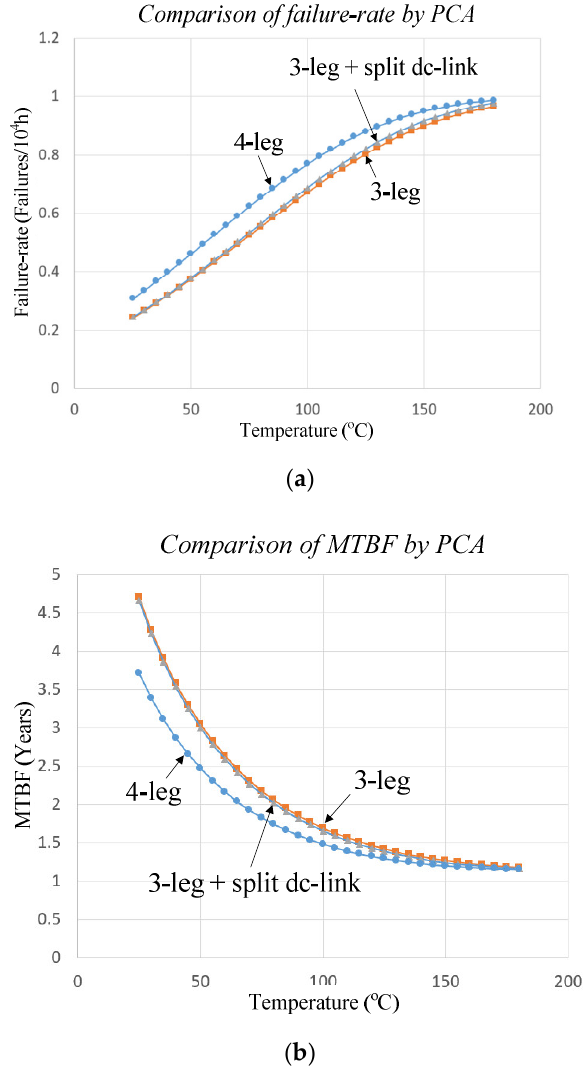
Figure 8. Comparison of failure rate and mean time between failures (MTBF) by part count failure analysis (PCA): ( a ) Failure rate; ( b ) mean time between failures.